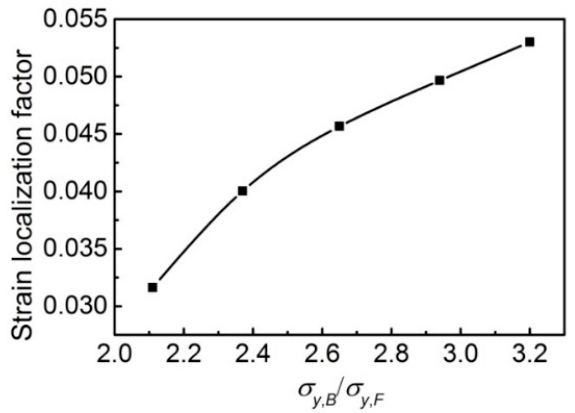
Figure 7. SLF vs. σ y , B / σ y , F of the models. Figure 7. SLF vs. 𝜎 (cid:3052),(cid:3003) /𝜎 (cid:3052),(cid:3007) of the models.